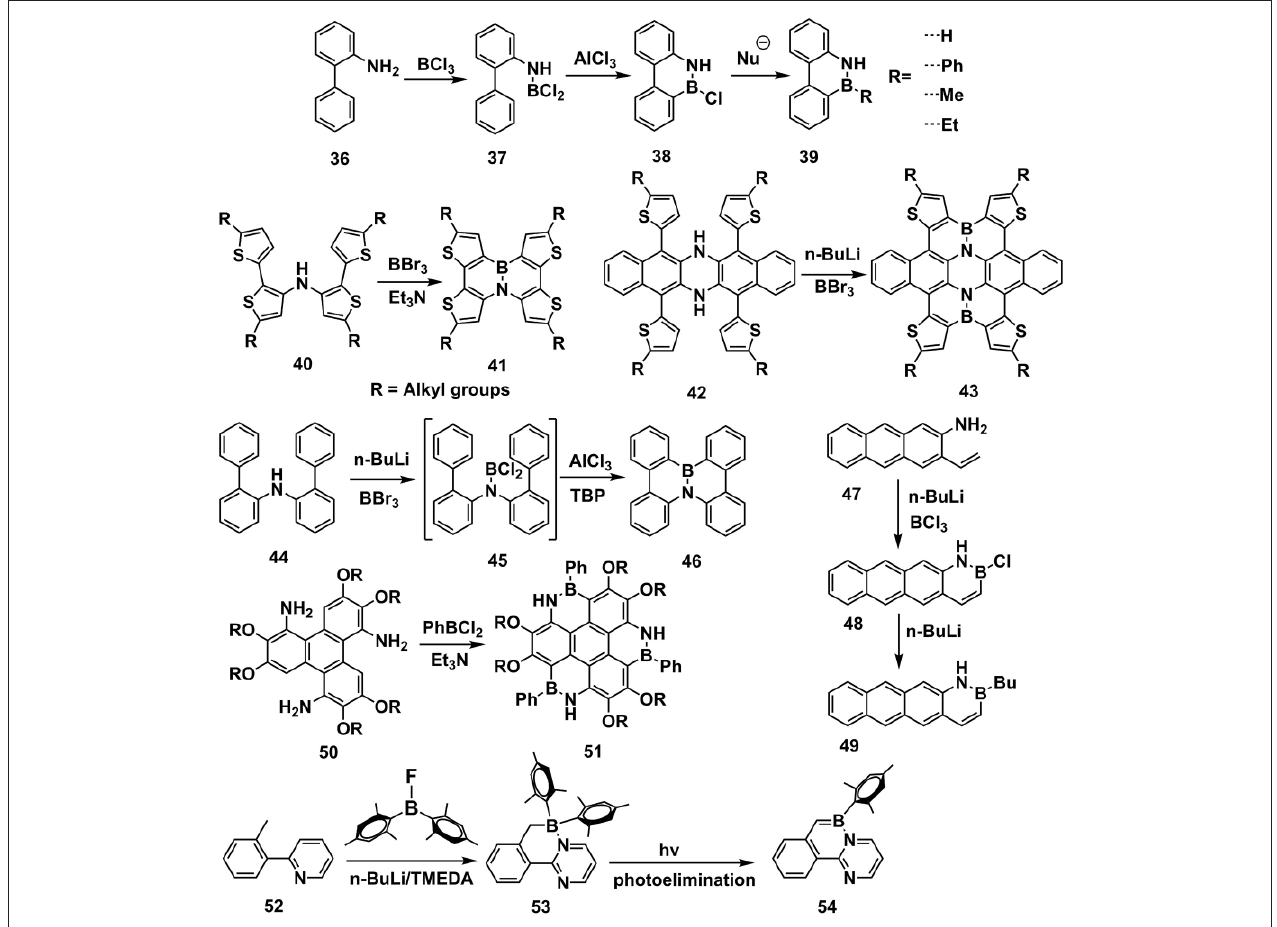
FIGURE 5 | Examples of synthesis routes toward B-N embedded units via electrophilic cyclization between boron and aromatic units.